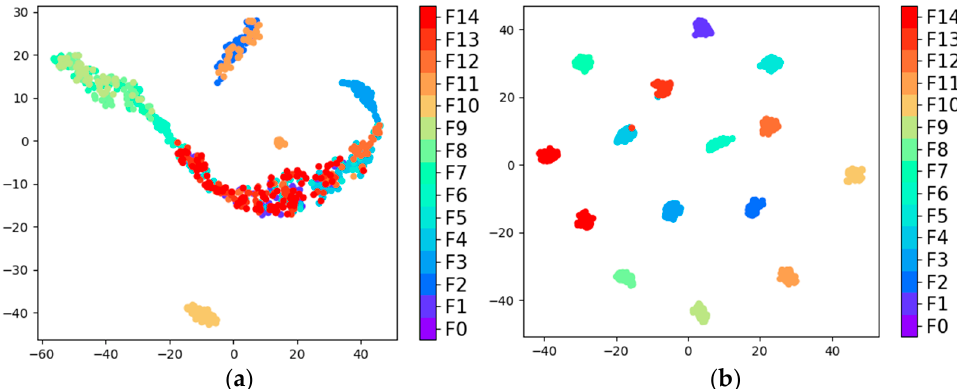
Figure 13. Dimensionality reduction visualisation of CSTV filter circuit responses based on t-SNE. ( a ) Visualisation of the original response signal; and ( b ) visualisation of features extracted by Model . optima